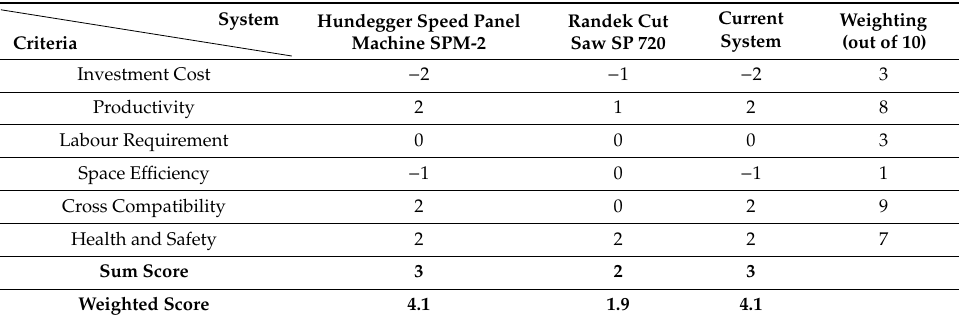
Table 4. Resultant scores for cutting and